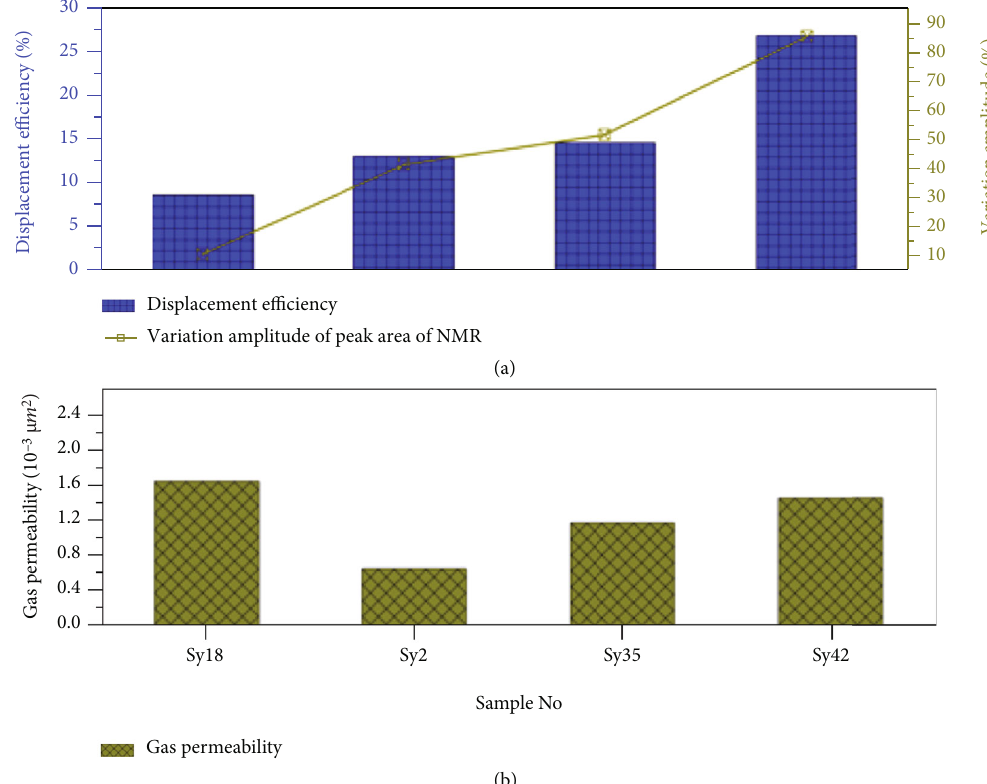
Figure 12: NMR T spectra before and after water fl ooding. The red line represents the T 2 represents that after water fl ooding.